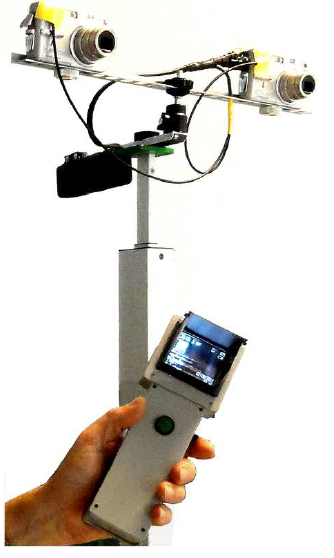
Figure 3. 2 nd generation Alu telescope staff 3D